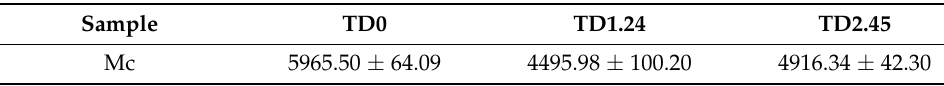
Figure 5. Tensile curves of typical silicone tie-coating samples. Table 3. Mc value of typical tie-coating samples.